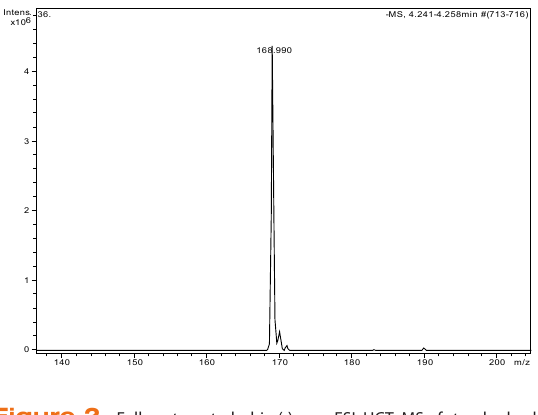
Figure 2. Fully automated chip (-) nanoESI HCT MS of standard gallic acid. Solvent: MeOH; ESI/MS parameters: ChipESI: -1.4 kV; capillary exit: -50 V. Back nitrogen pressure 0.30